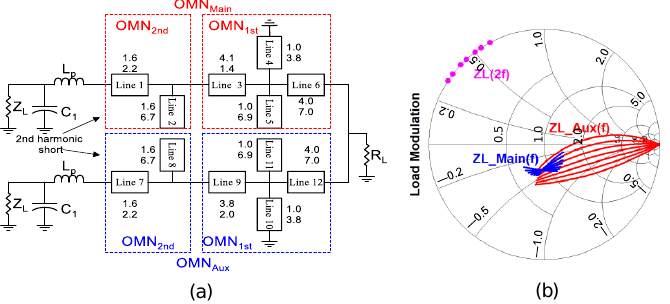
Figure 4. ( a ) Schematic of the OMNs (dimension length and width are in millimeters), and ( b ) corresponding simulated fundamental and second harmonics load modulation for the main and auxiliary PAs.